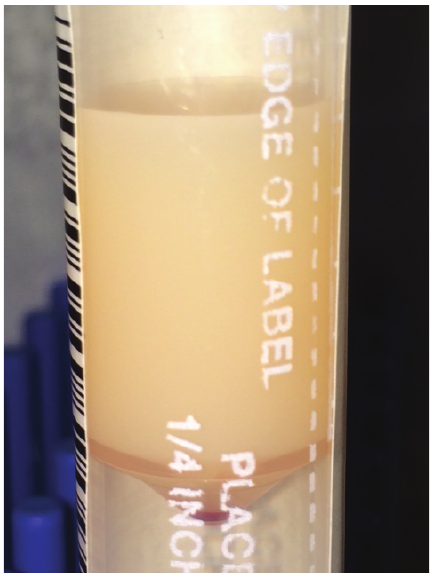
Figure 1: A sample of the chylous ascitic